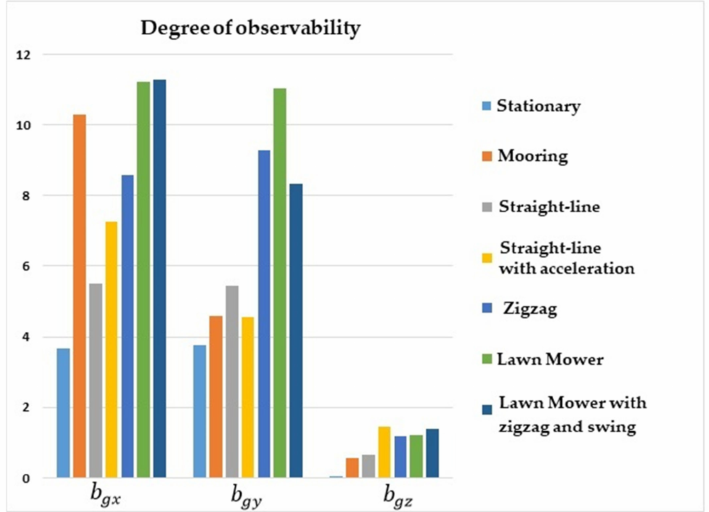
Figure 6. Degrees of observability of the gyro biases. INS/DVL/PS